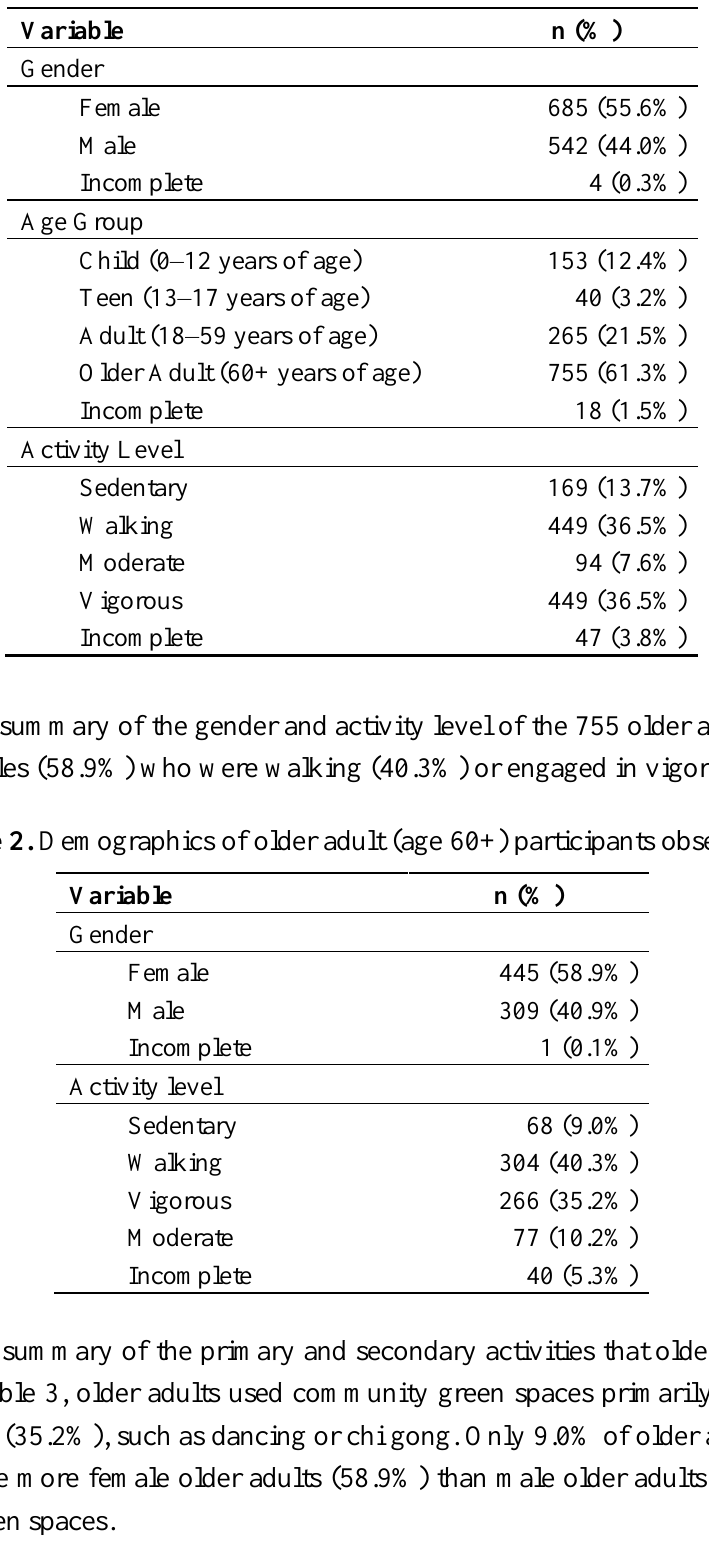
Table 1. Demographics of all participants observed.